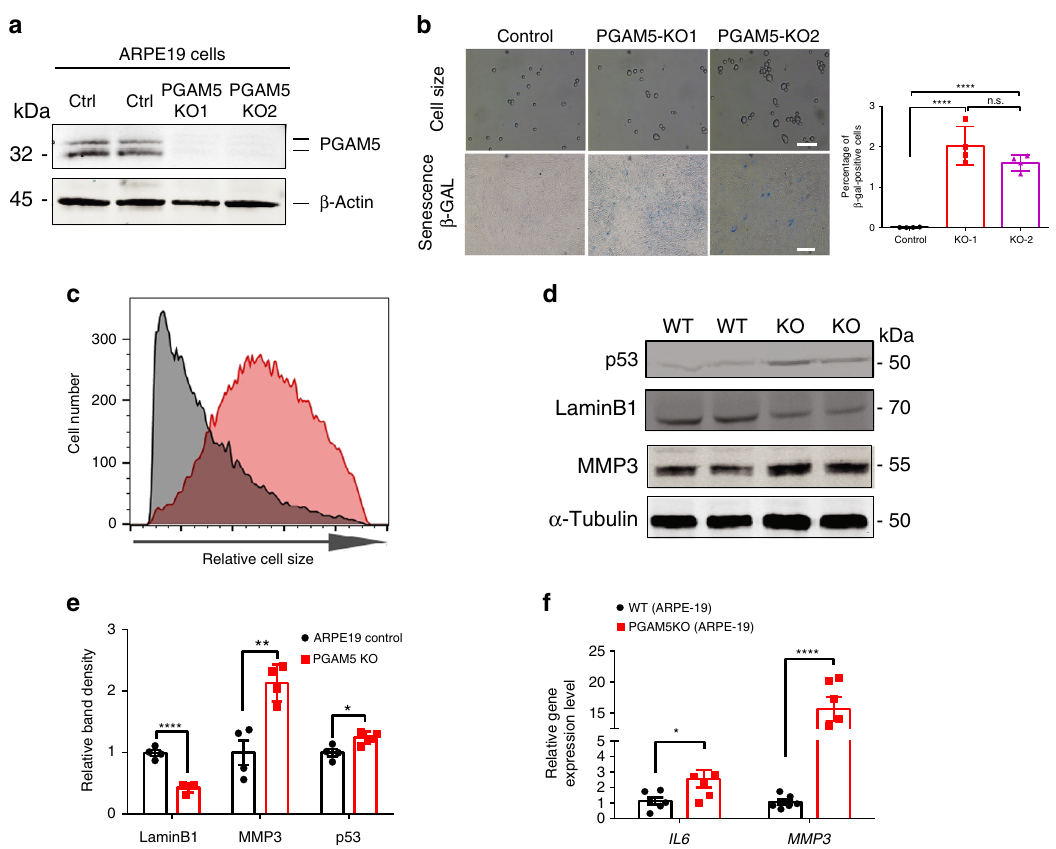
Fig. 2 Cellular senescence induced by PGAM5 deletion in vitro. a Western blot con fi rming PGAM5 deletion in ARPE-19 cells using CRISPR/Cas9 technology. β -Actin was used as a loading control. n = 3. b Top panel: cell size change detected in PGAM5 − / − ARPE-19 cells after 8 weeks culture and trypsinization; bottom panel: SA- β -gal activity change detected in PGAM5 − / − ARPE-19 cells after 8 weeks culture; quanti fi cation of β -gal staining was shown in the bar graph (right panel). n = 4. Scale bar = 100 µ m (up panels) or 500 µ m (down panels). **** p < 0.0001, one-way ANOVA Tukey ’ s multiple comparisons test. Error bars, mean ± s.d. c Relative cell size distribution in WT and PGAM5 − / − ARPE-19 cells after 8 weeks culture as measured by fl ow cytometry. X axis is FSC-A, which re fl ects cell size. n = 3. d Western blots con fi rming p53 and MMP3 upregulation and Lamin B1